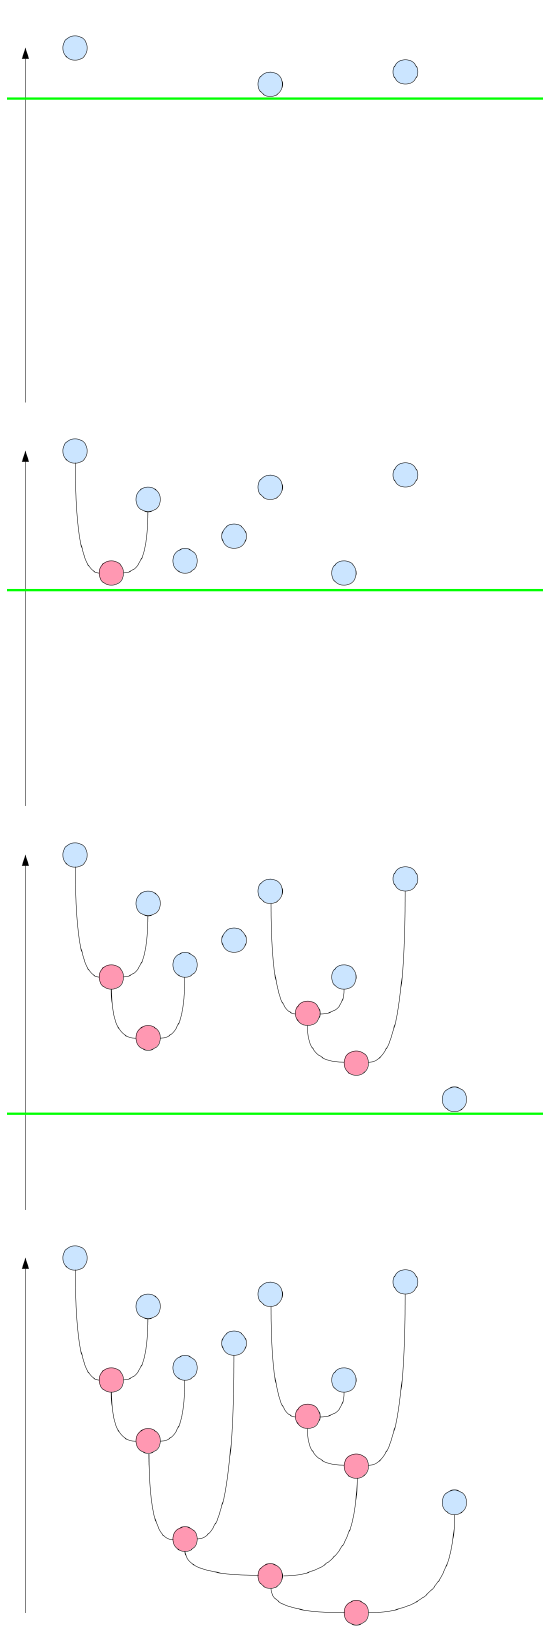
Figure 3: Representation of persistence tree computation: red leafs correspond to the apparition of a component, blue nodes to the merge of two components, green line to the current